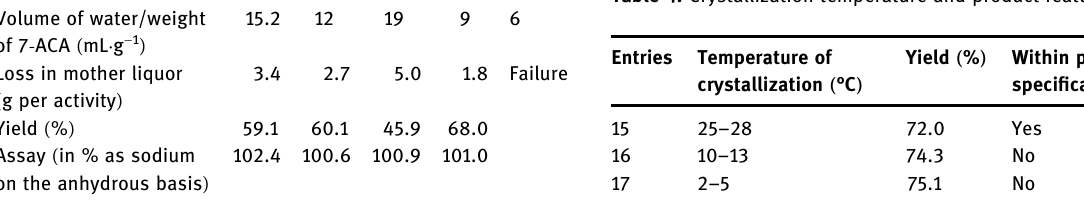
Table 4: Crystallization temperature and product